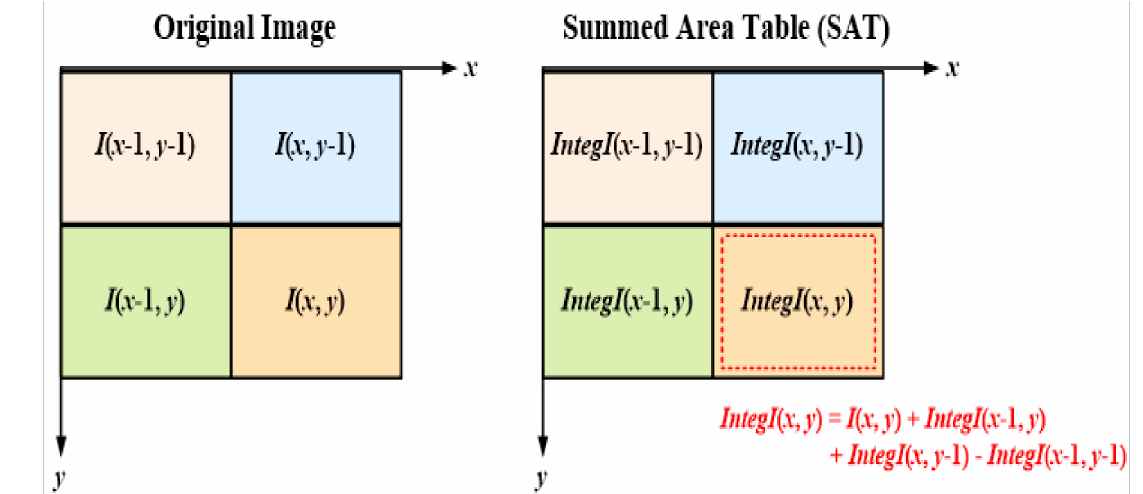
Figure 2. Summed area table (SAT) to indicate the generating sum of values in a rectangular section for integral image (II) process at the location ( x , y